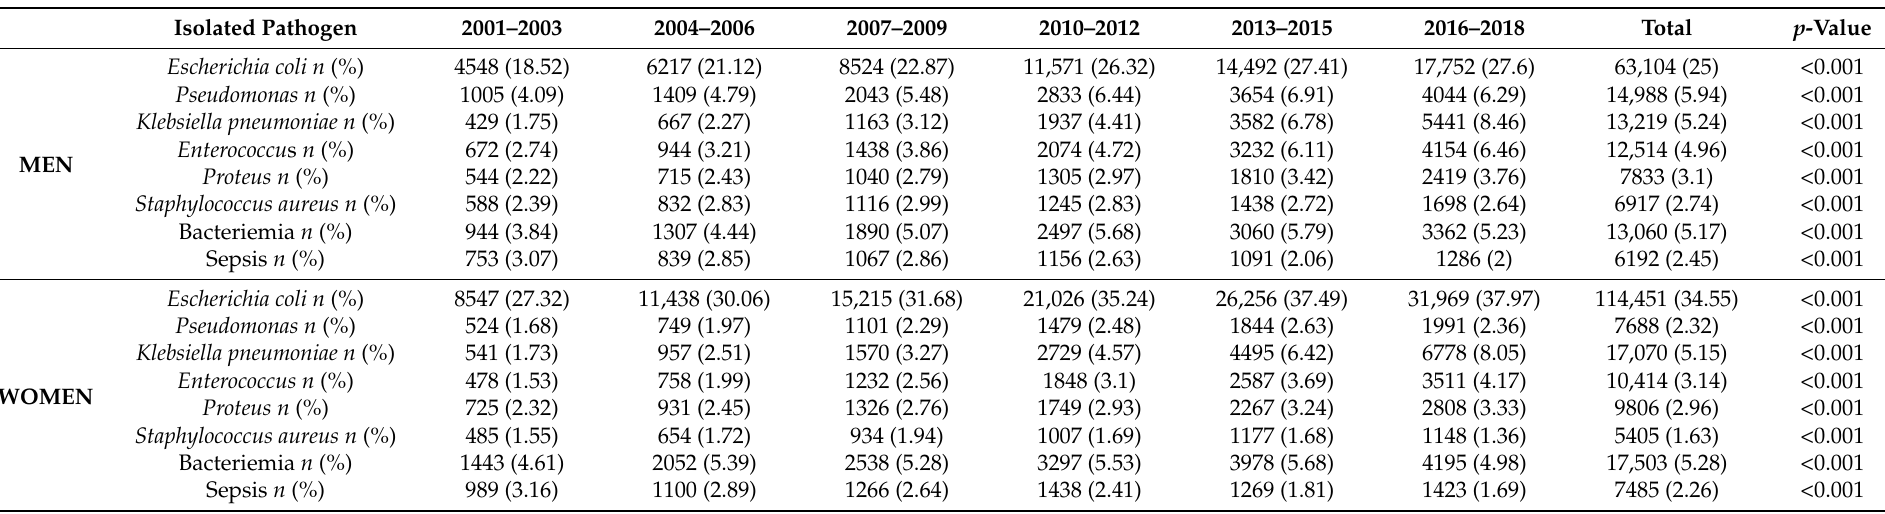
Table 5. Isolated pathogens, bacteremia, and sepsis codified in hospital admissions among elderly patients with a principal diagnosis of urinary tract infection according to sex in Spain